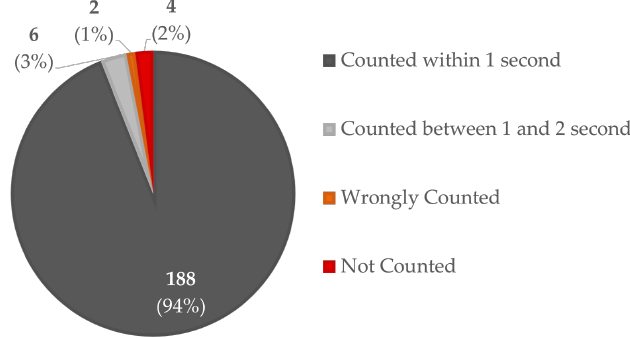
Figure 12. Results of the Real-time Counting Application Responsiveness